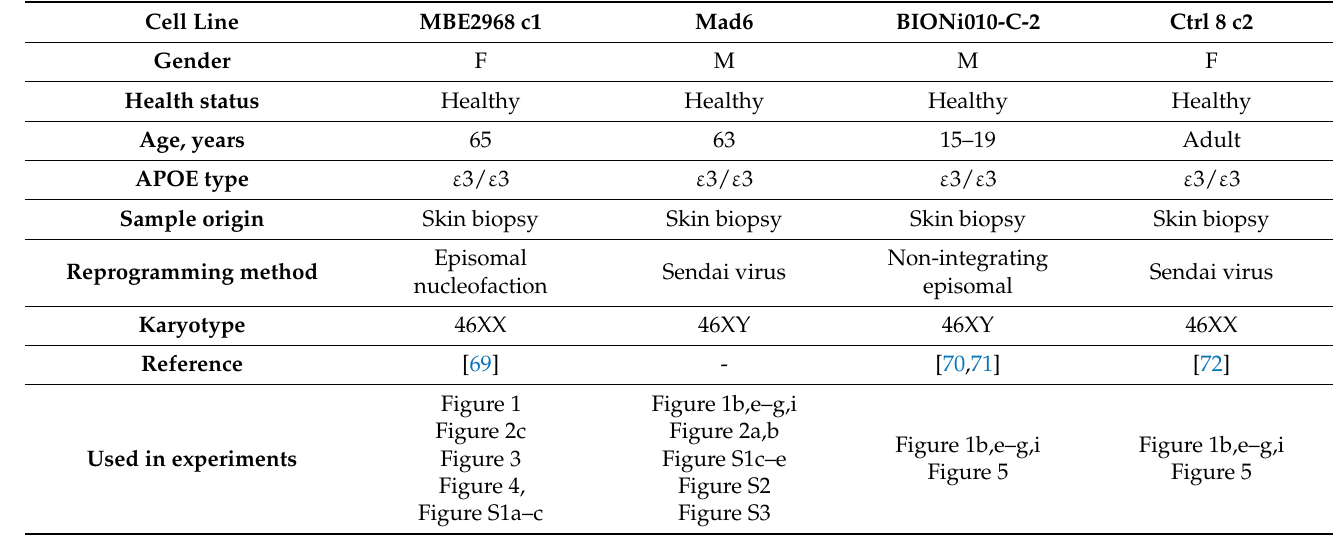
Table 1. Lines of induced pluripotent cell used in the presented work.